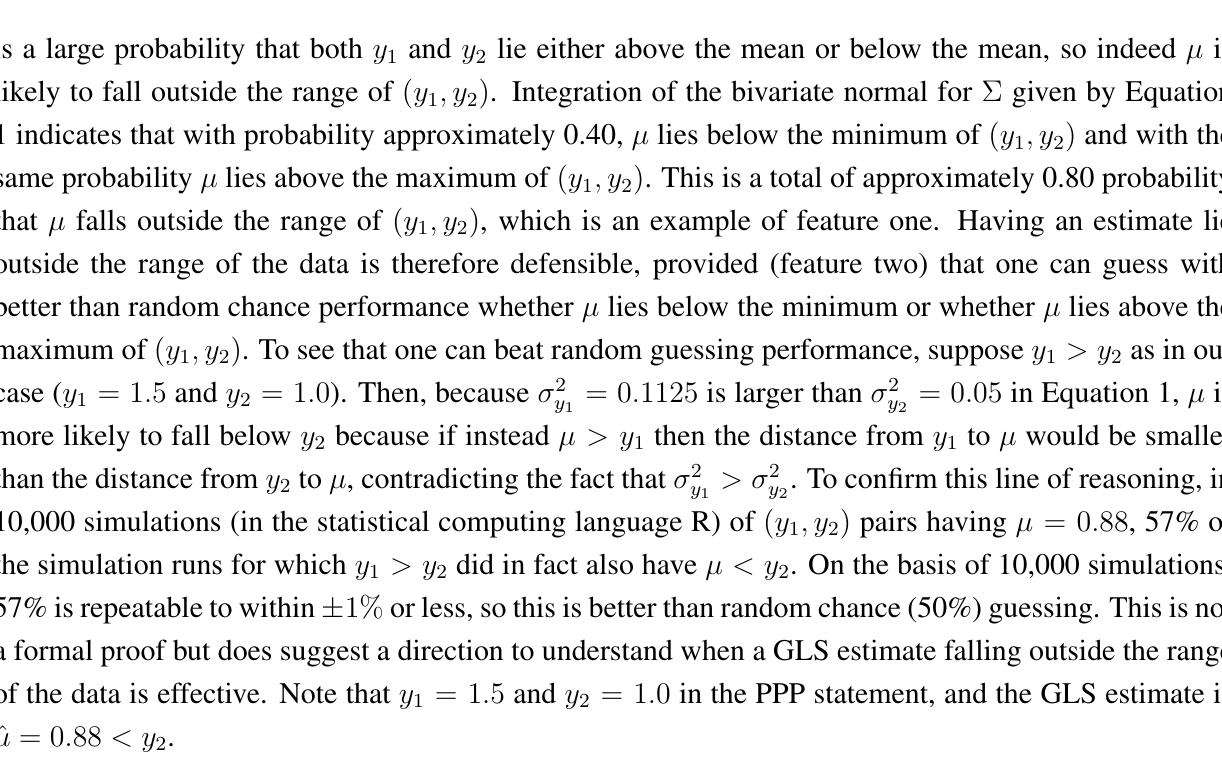
and y illustrating that µ = 0 . 88 1 2 , y ) falling 1 2